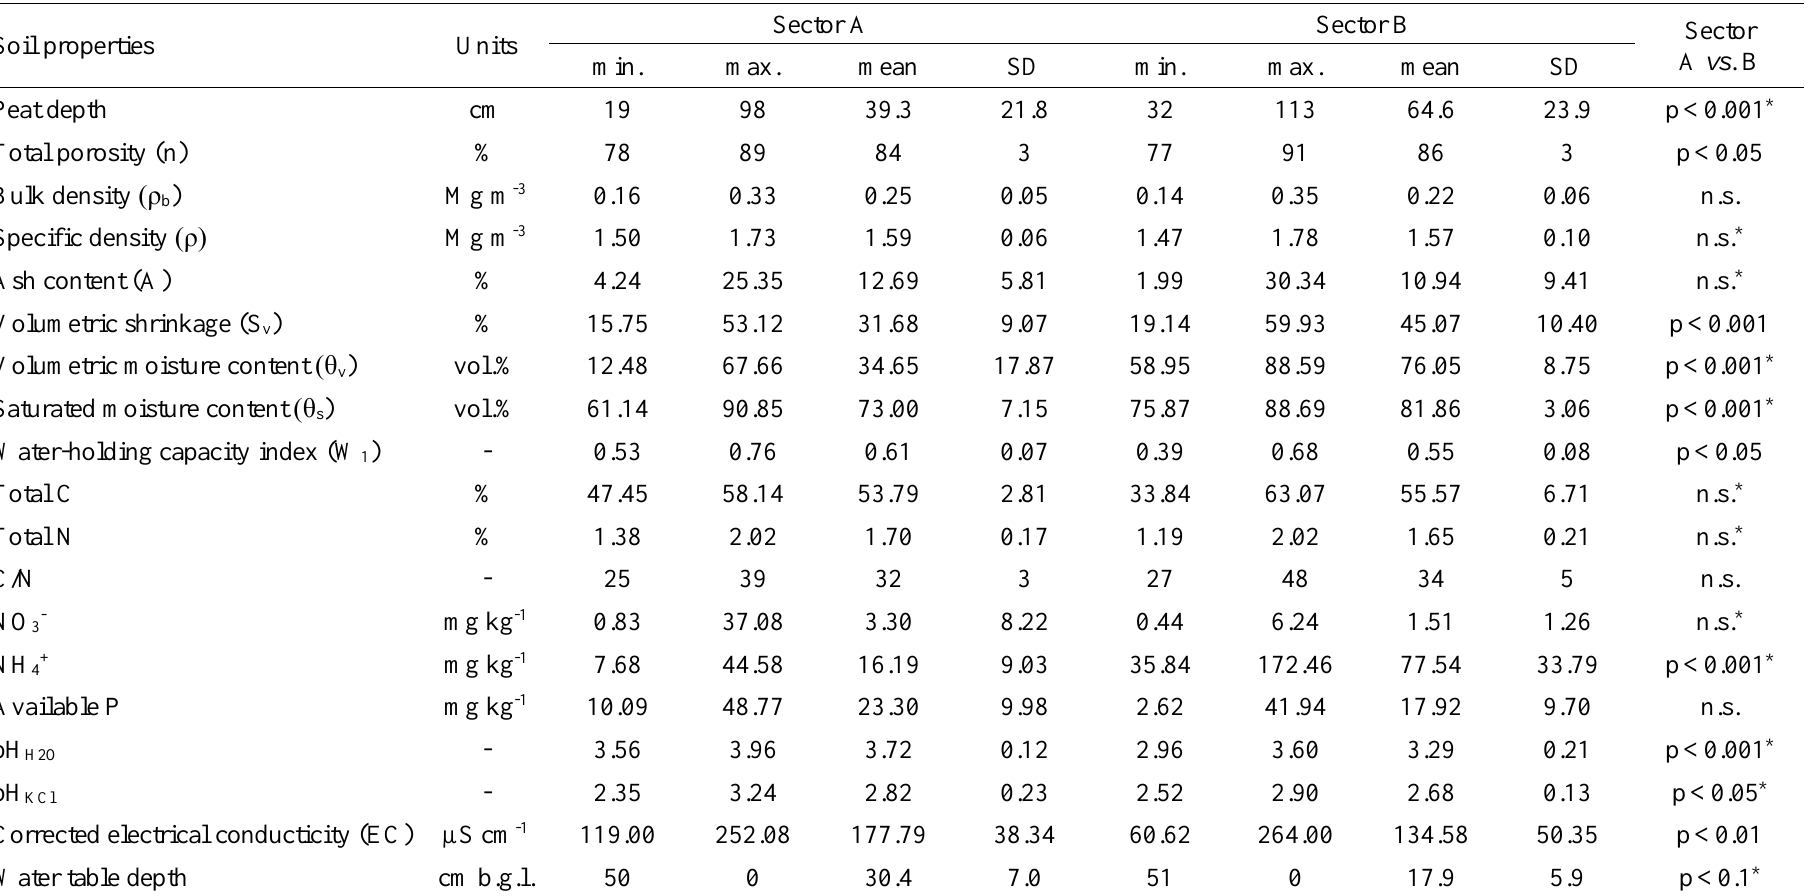
Table 1. Comparison of soil properties for the uppermost 10 cm of peat, between Sector A and Sector B. Significance was tested with a parametric t-test or a non- parametric Mann-Whitney U-test; * comparison of medians with non-parametric Mann-Whitney U-test. Key: SD = standard deviation; n.s. = non-significant at p < 0.05; b.g.l. = below ground